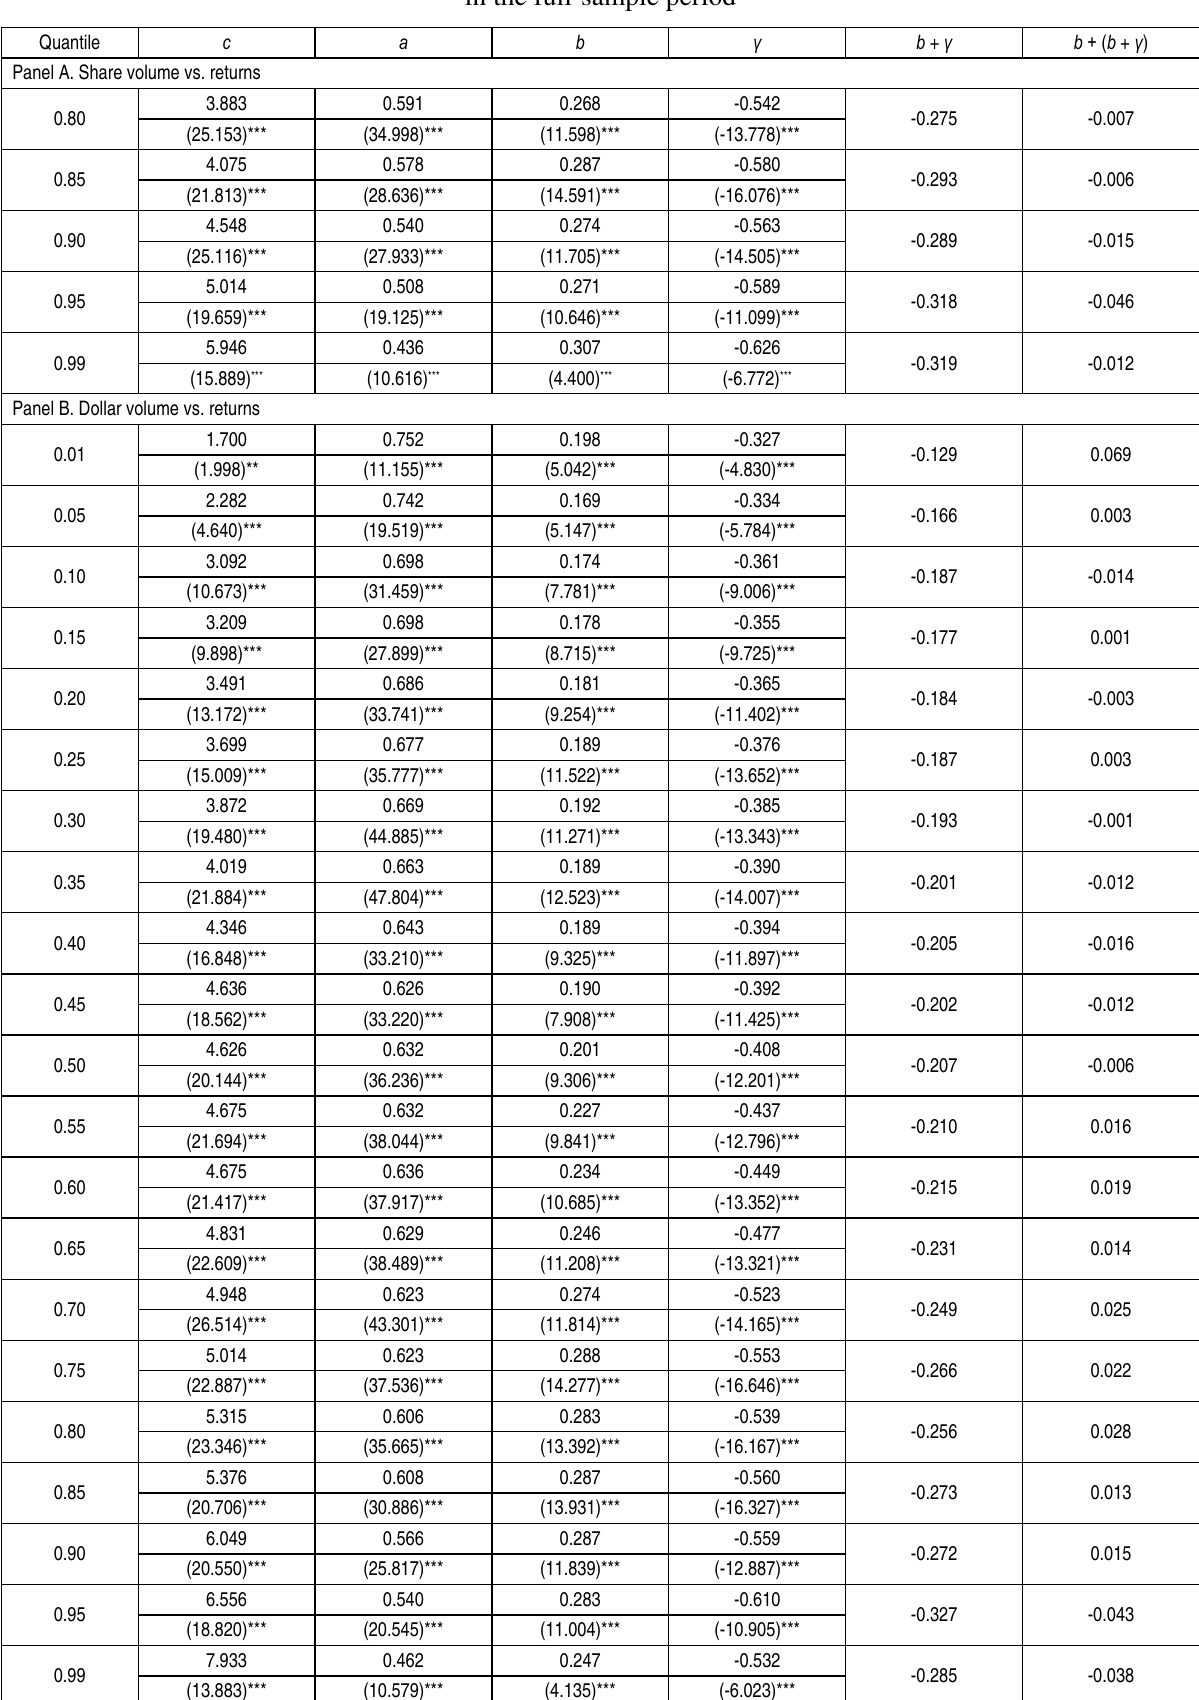
Table 5 (cont.). Quantile regression estimates of volume-signed return correlation for Taiwan 50 ETF in the full-sample